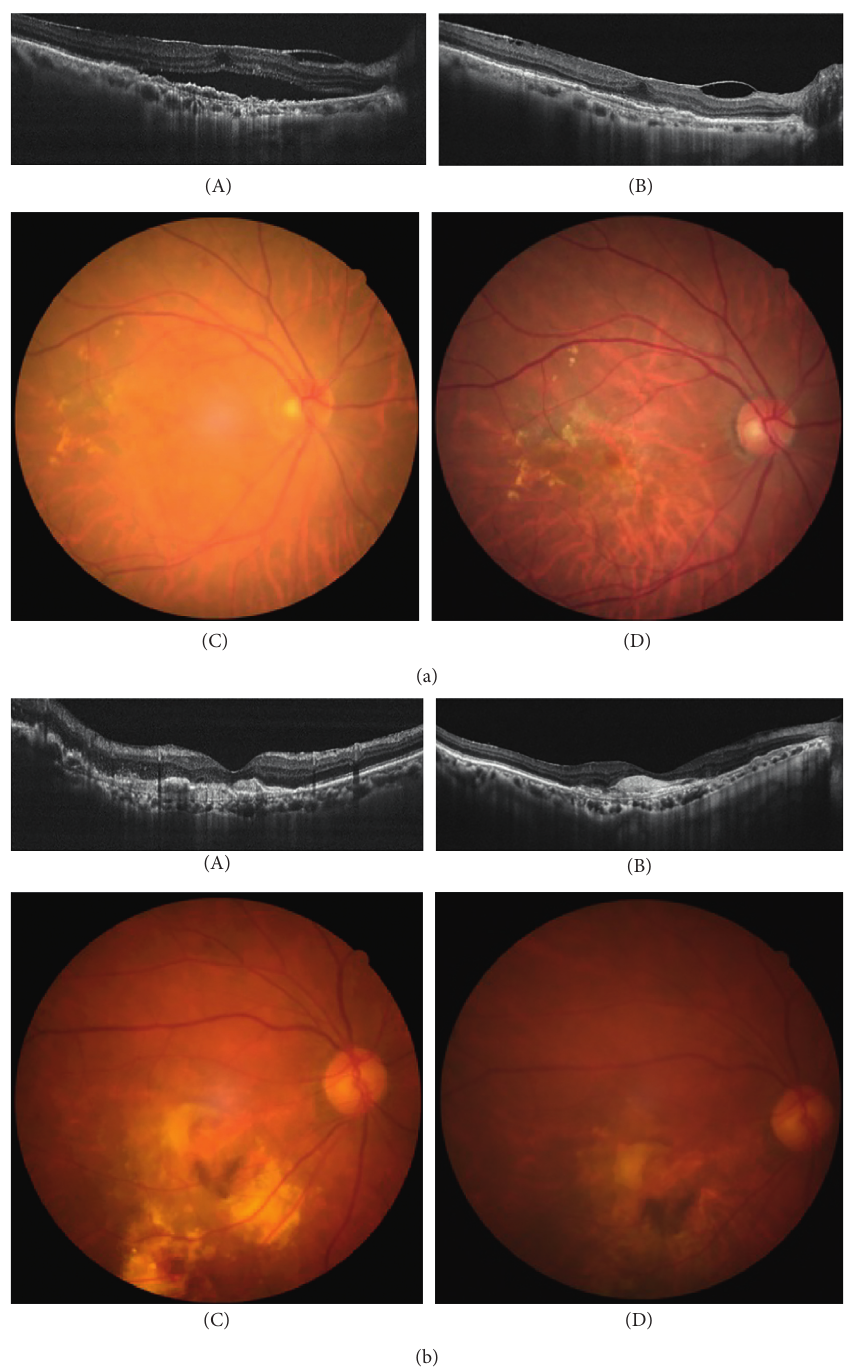
Figure 4: (a) An 80-year-old female who was diagnosed nAMD during her first visit. After receiving 7 doses (6 doses in the first year) of aflibercept injections within three years, her vision improved from 0.52 to 0.10 in logMAR. Fundus photography and OCT before treatment (A, C) and three years after treatment (B, D). (b) An 87-year-old female who was diagnosed nAMD during her first visit. After receiving 3 doses (3 doses in the first year) of aflibercept injections within three years, her vision decreased from 1 in logMAR to hand motion. Fundus photography and OCT before treatment (A, B) and three years after treatment (C,